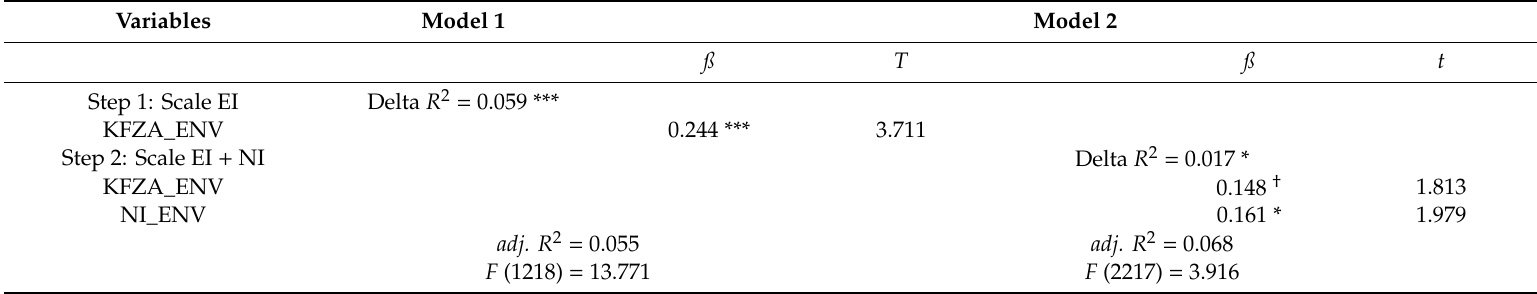
Table A2. Hierarchical regression analyses for the relation between well-being and scales from existing instruments (EI) and the new instrument (NI) working environment.